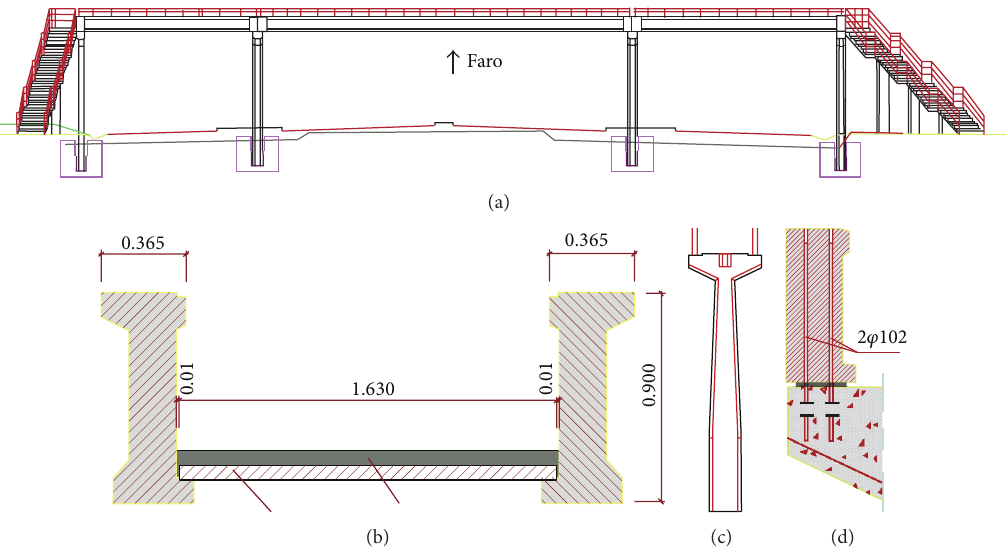
Figure 17: RC footbridge in Faro: (a) front view; (b) cross-section with precast (I + slab + I); (c) central column (longitudinal view); (d) column-beam connection (units in